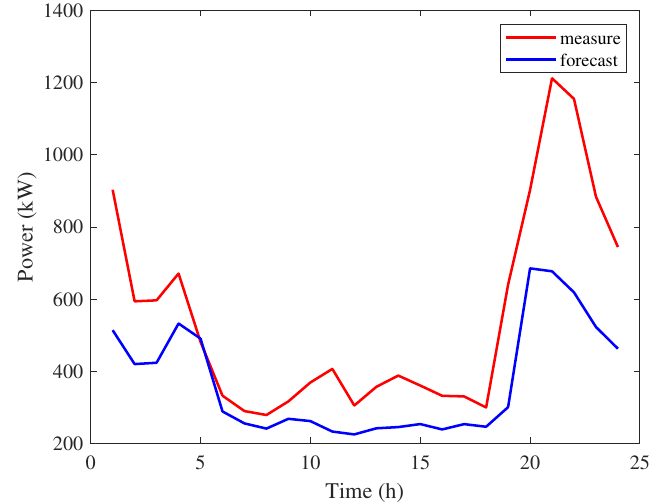
Figure 6. Forecast and actual of load profile data for peak